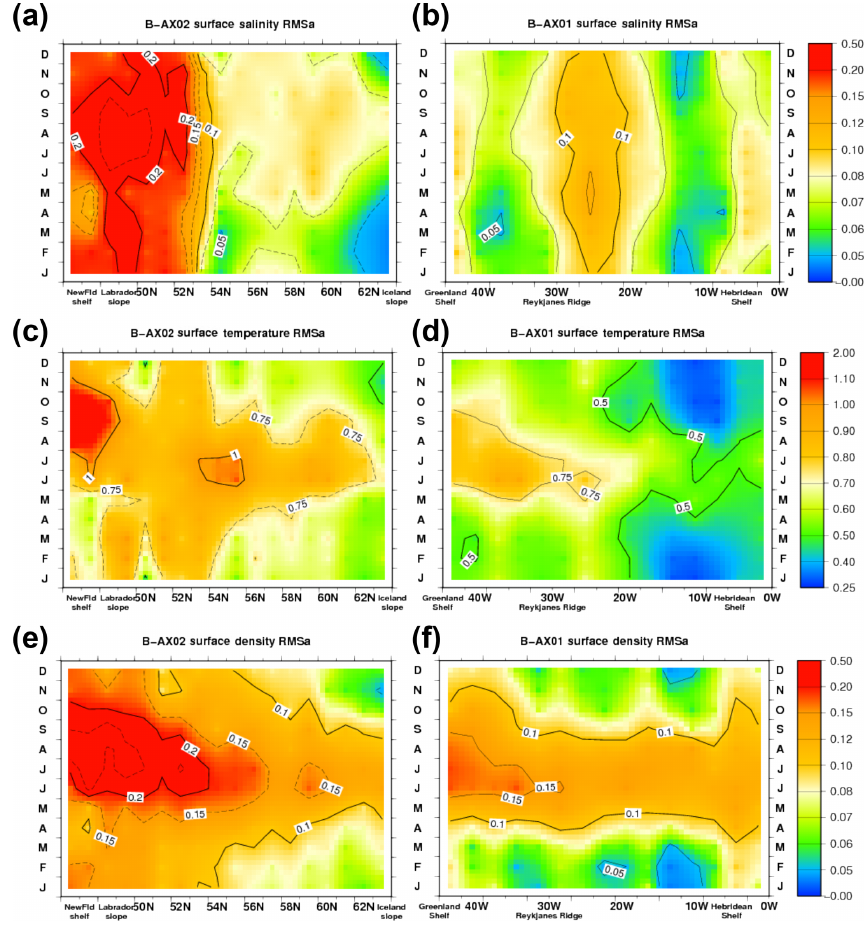
Figure 4. Seasonal cycle of interannual variability standard deviation RMSa: (a, c, e) along B-AX02; (b, d, f) along B-AX01. S (a, b) , T ( c, d , ◦ C), and density ( e, f , kgm − 3